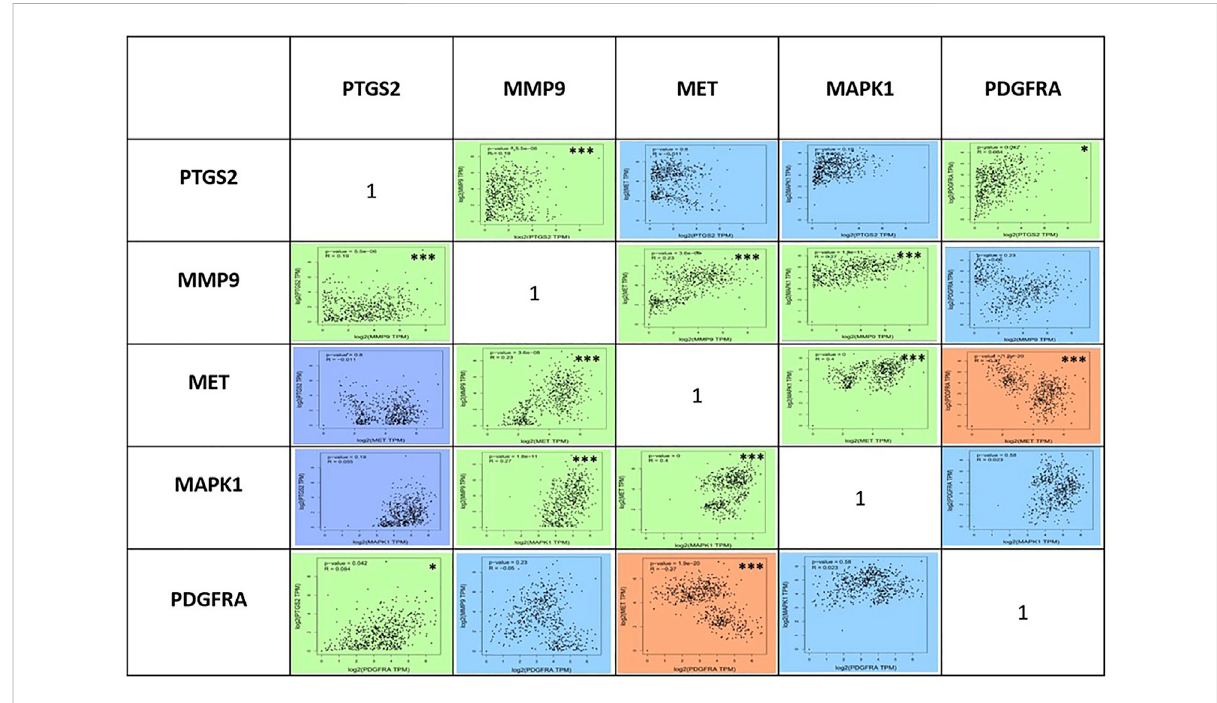
FIGURE 9 Box plots depicting expression levels of fi ve genes in COAD-Colon Adenocarcinoma and READ-Rectum Adenocarcinoma database for tumor group(red)andnormalgroup(grey).MMP9andMETwereover-expressedintumorgroups(COADandREAD),whilePTGS2(READ)andPDGFRAwas under-expressed (COAD and READ) in tumor